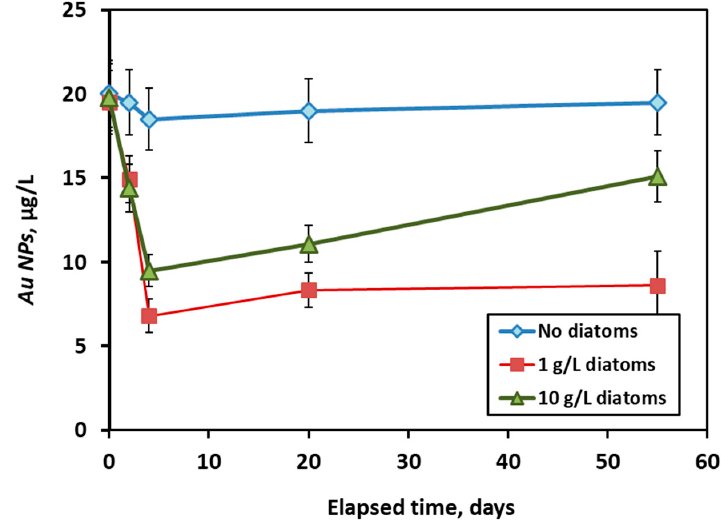
Figure 11. Concentration of AuNPs in 5 mM NaCl + 5 mM NaHCO 3 solution at pH = 8.7 ± 0.2 under light in the presence of 1 and 10 g wet /L of live diatoms (green triangles and red squares, respectively). The error bars (standard deviation of duplicates) are shown by vertical lines.